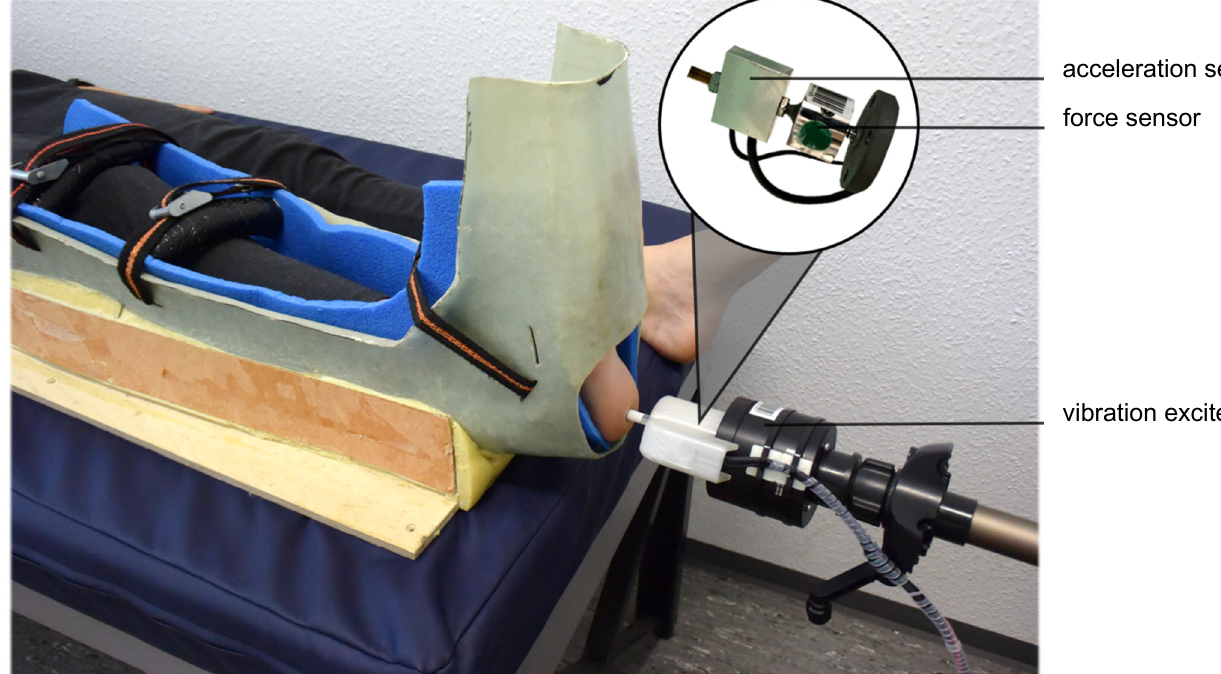
Figure 1. Measurement setup. The 7.8 mm diameter probe (area ~48 mm 2 ) of the modified vibration exciter placed perpendicularly at the plantar heel of the right foot. To keep the test person’s foot as still as possible, the foot was strapped into a cushioned splint. The contact forces (0.3 N, 0.6 N, 1.2 N, 2.4 N, 4.8 N, and 9.6 N) were adjusted and continuously monitored using a force sensor. The amplitude of the vibration was measured directly in micrometers using an accelerometer.